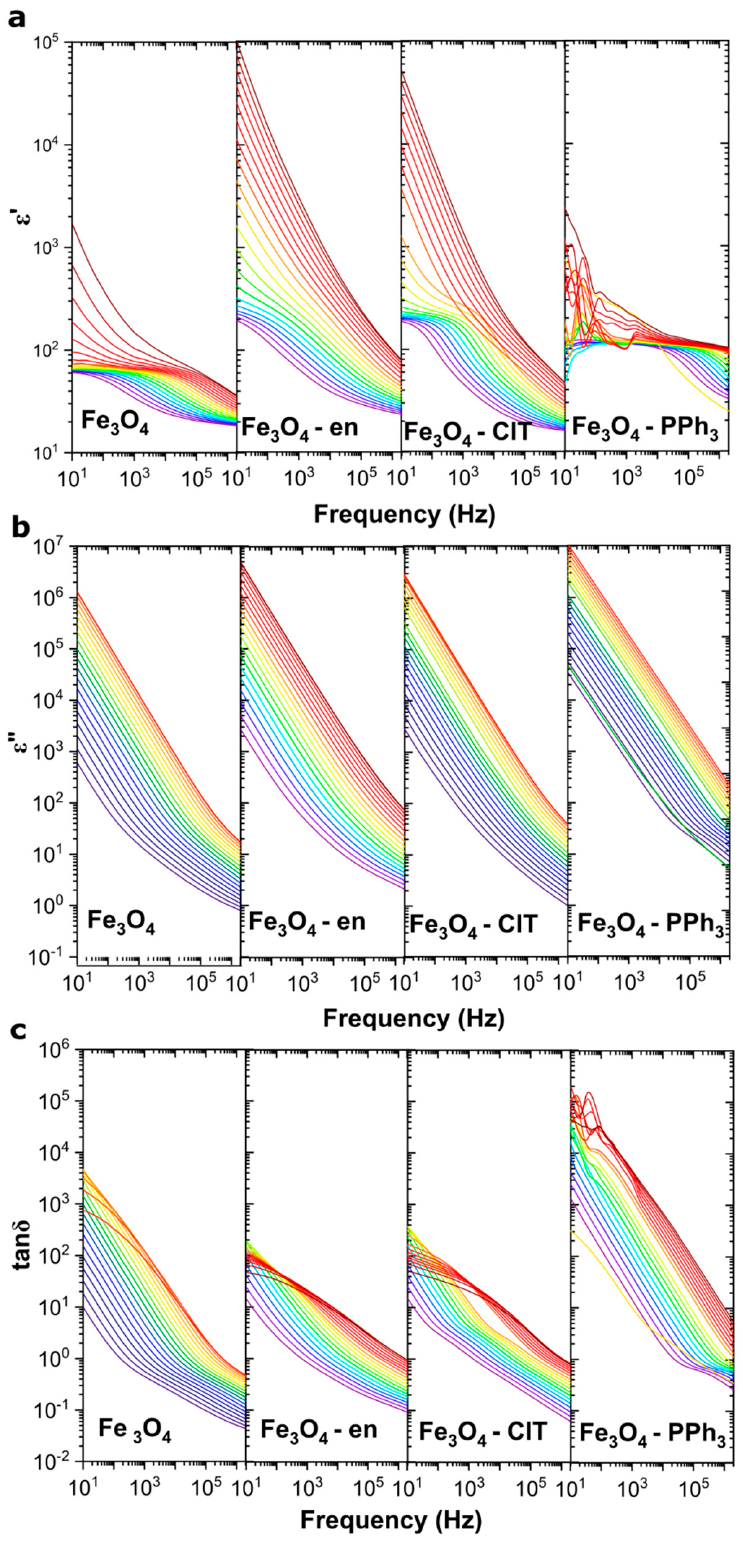
Figure 5. Dielectric properties of magnetite nanoparticles with different shapes and oxidized surfaces: real ( a ) and imaginary ( b ) parts of permittivity, ( c ) loss tangents in different temperatures from 173 K (violet line) to 363 K (red line) with Δ T = 10 K.